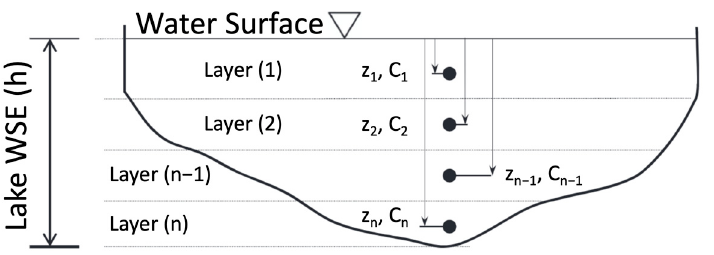
Figure 4. Hypothetical lake at WSE h with n number of measurements at depth on a given day. Cross-sections indicate layers used to calculate average dissolved salt mass and average salinity. Adapted with permission from Ref. [26], Copyright American Geophysical Union, 2012.